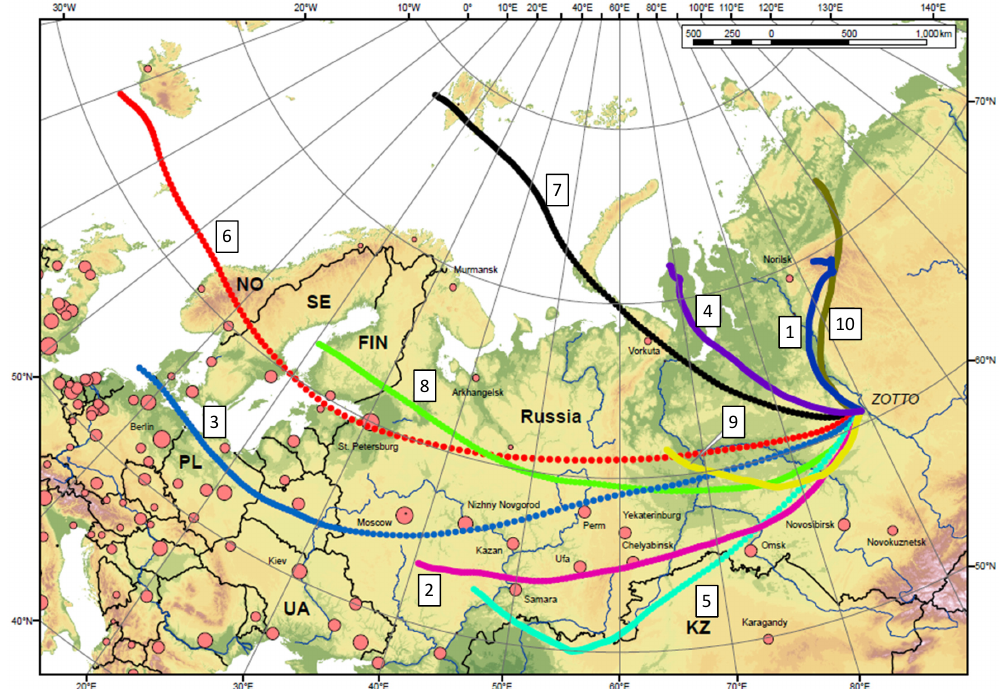
Fig. 8. Mean back trajectories arriving at ZOTTO as obtained from k -means cluster analysis. The travel time of all trajectories is 144h. The cluster numbering ranks the seasonality of the observations, ranging from cluster 1 (predominantly winter periods, season index − 0.8) over cluster 6 (no preference, season index − 0.1) to cluster 10 (predominantly summer periods, season index +0.6). Circles indicate urban agglomerations with the diameter of the symbol being proportional to the population